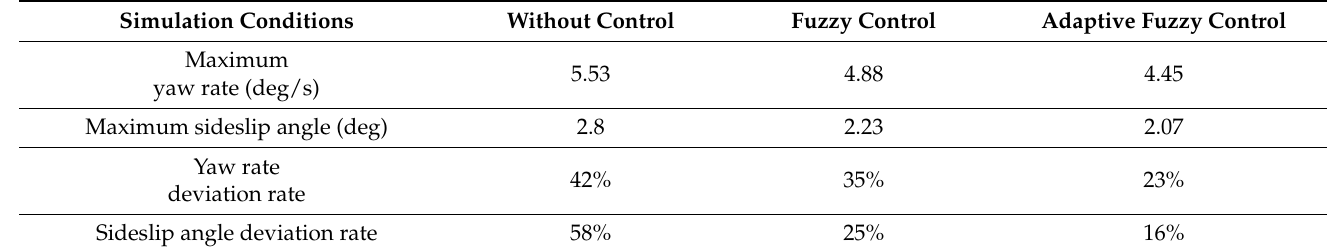
Figure 17. ( a ) Speed, ( b ) torque, ( c ) yaw rate, ( d ) sideslip angle, and ( e ) lateral acceleration. Table 4. Comparison of the simulation results with a small steering angle at high speed.